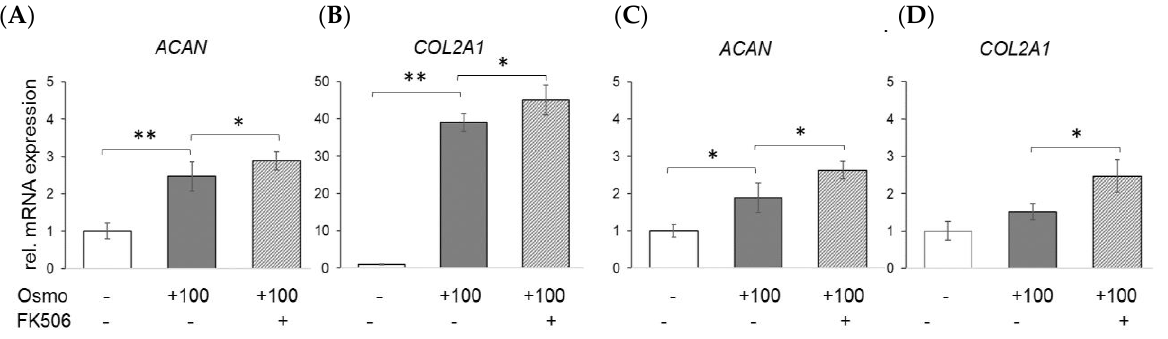
Figure 5. Effects of physosmotic culture and FK506 stimulation on human primary chondrocytes in vitro and in situ. ( A , B ) Chondrocytes were cultured for 7 days and ( C , D ) explants for 10 days, respectively. Relative changes in mRNA expression are shown as compared to iso-osmotic controls without FK506. Only the expression of main ECM markers aggrecan ( ACAN ) and collagen type II ( COL2A1 ) are shown. Error bars indicate standard deviations from triplicate experiments; *, p < 0.05; **, p <